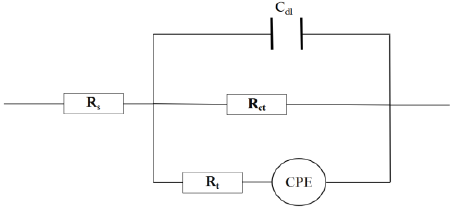
Figure 7. Fitting equivalent circuit Figure 7. fitting equivalent circuit diagram.